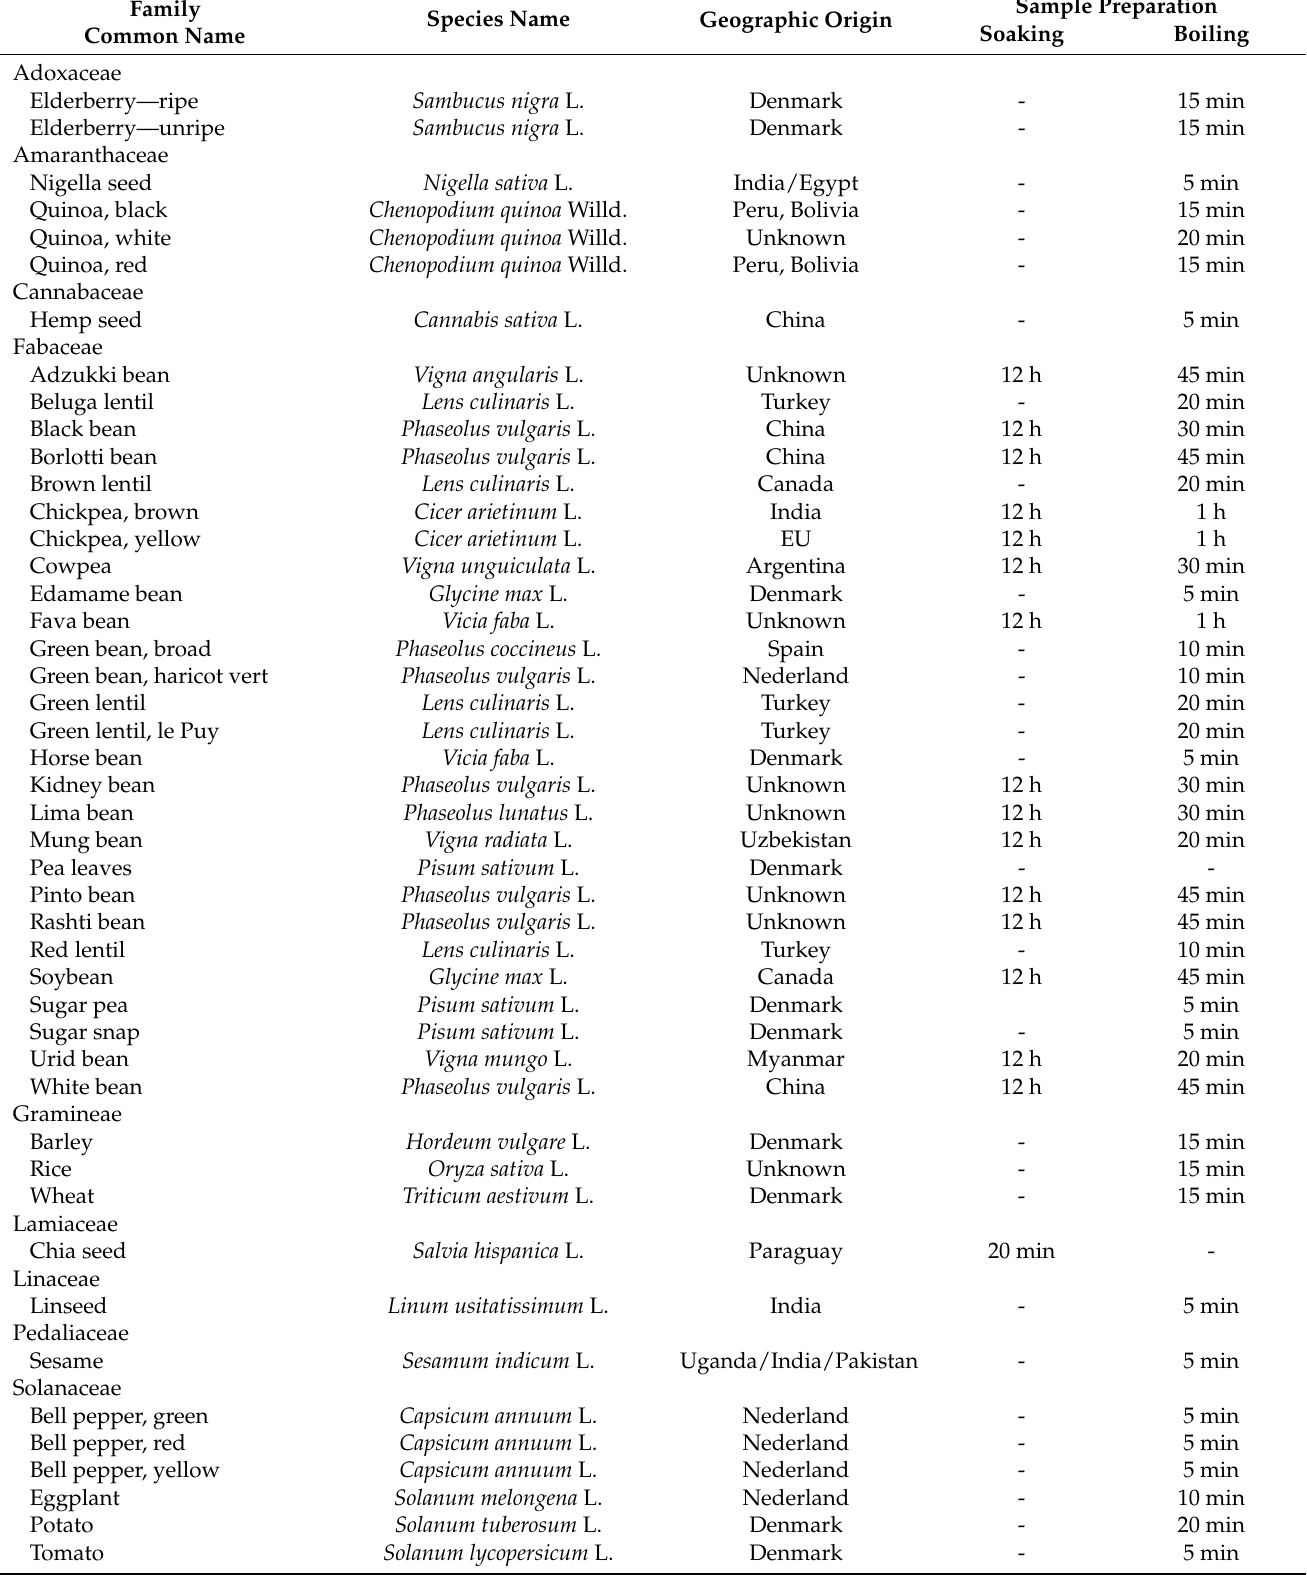
Table 2. Common names, species names, geographical origin, and sample